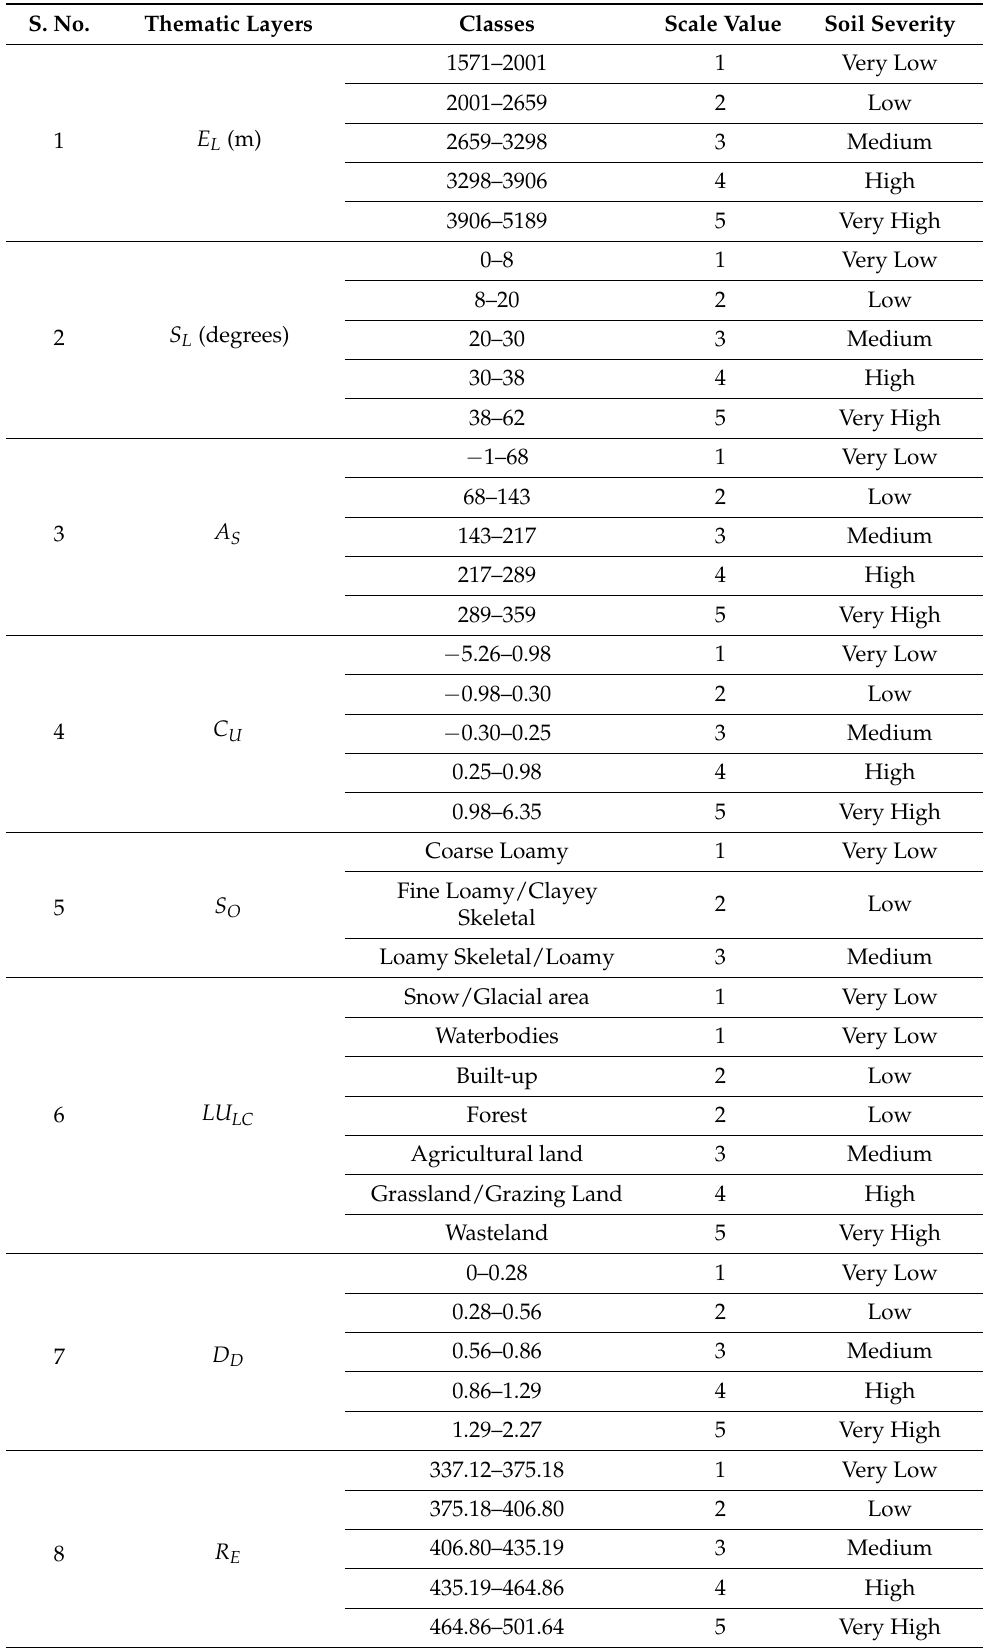
Table 3. Scale value assigned to different thematic layers as per the soil erosion severity. S.